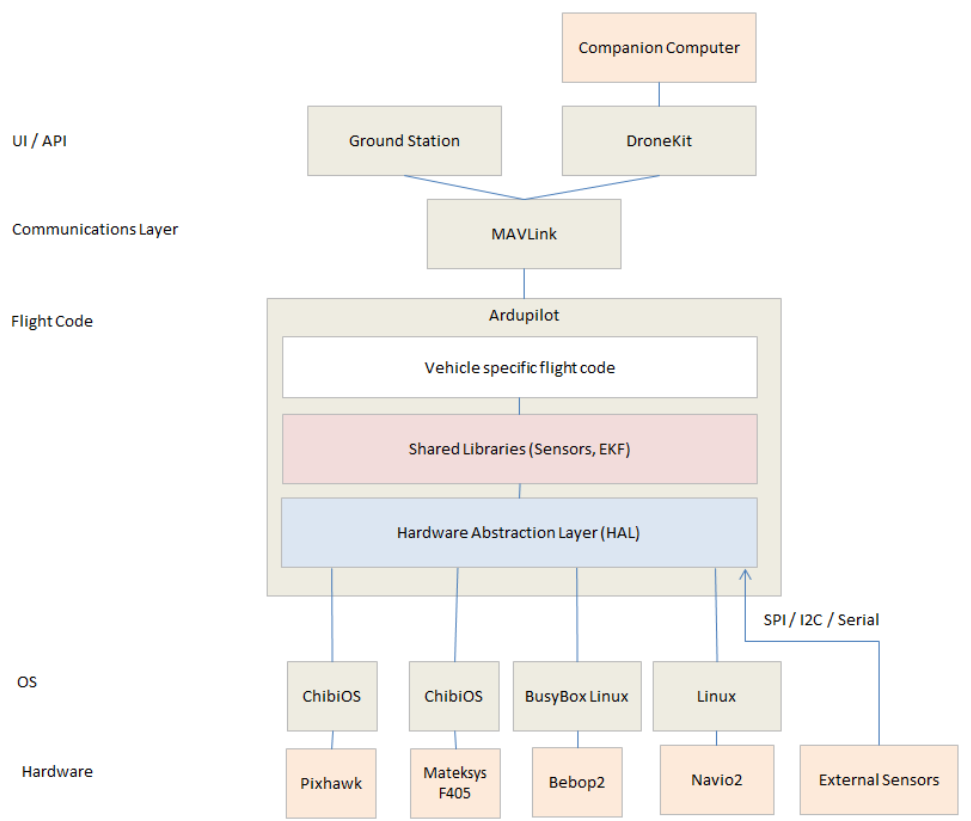
Figure 21. A high-level architecture overview of the ArduPilot software; image source: https:// ardupilot.org/dev/docs/apmcopter-code-overview.html, accessed on 1 May 2022; published under the CC BY-SA 3.0 license: https://creativecommons.org/licenses/by-sa/3.0/legalcode, accessed on 1 May